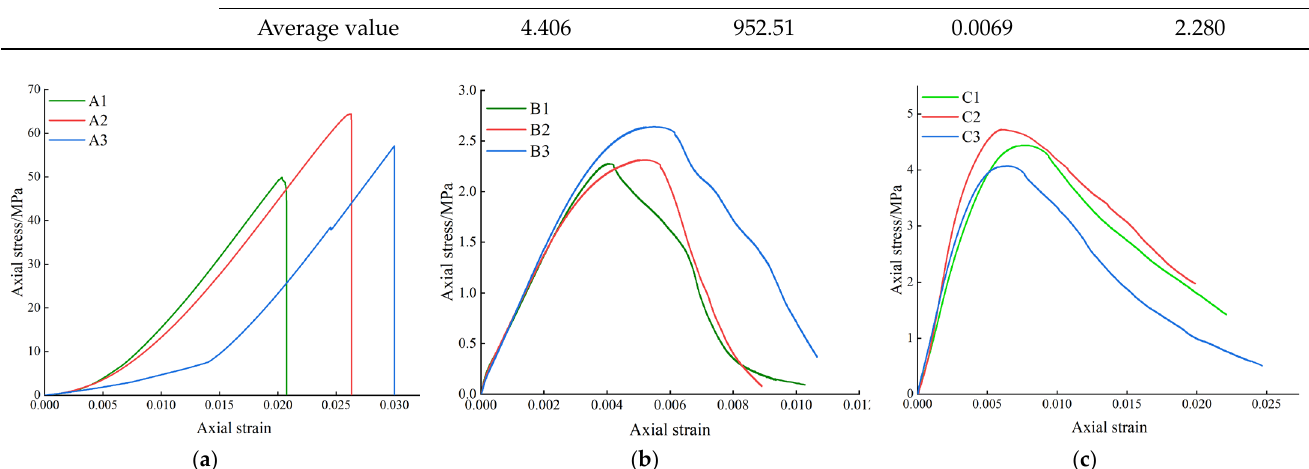
Figure 5. Stress–strain curves of pure sandstone, pure CGFB, and sandstone–CGFB composite samples. ( a ) Pure sandstone samples; ( b ) pure CGFB samples; ( c ) sandstone–CGFB composite samples.